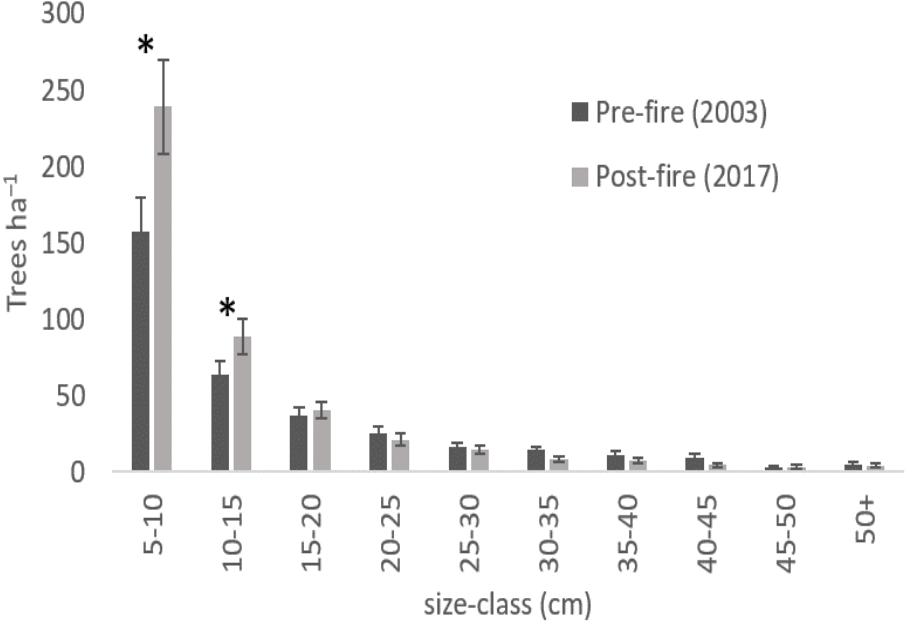
Figure 5. Mean size-class distributions of dead trees (+1 S.E.) measured in stand structure plots for the pre- and post-fire sampling intervals in Guadalupe Mountain National Park, Texas. Asterisks signify significant paired t -tests at p < 0.05.